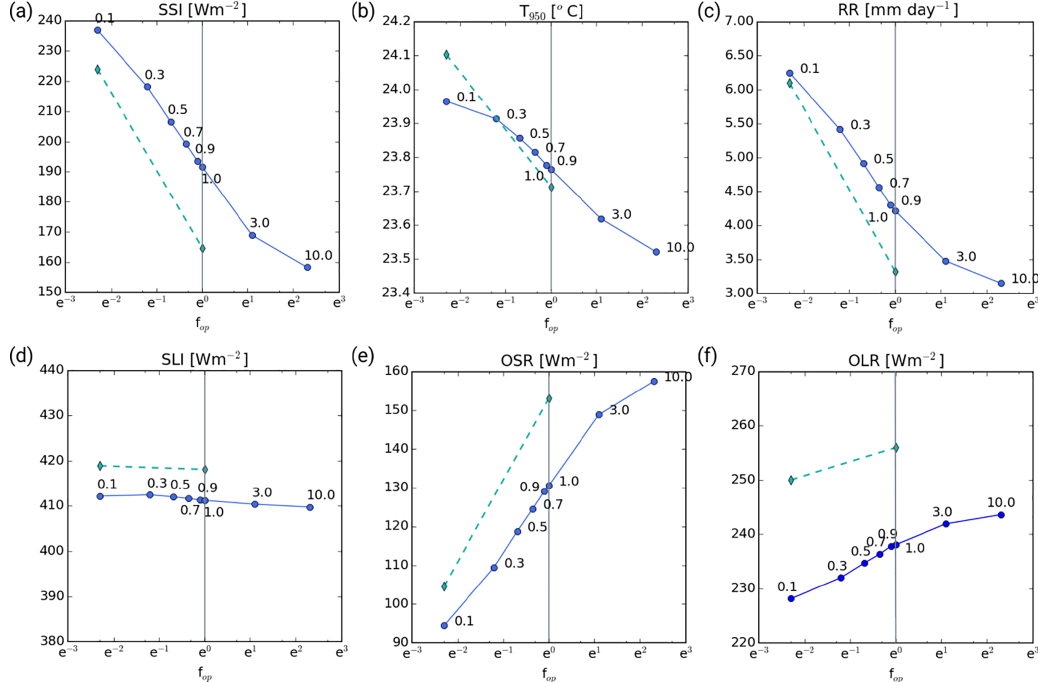
Figure 4. Averages over July 2006 and the DACCIWA box of SSI (a) , T at 950hPa (b) , precipitation (RR) (c) , SLI (d) , OSR (e) and OLR (f) depending on the opacity factor f op plotted with an exponential scale. ICON PARAM is depicted with solid blue lines, while the dashed cyan lines denote ICON EXPL (see Sect. 2.2.2). The thin grey line marks the position of the control run f op = 1 .